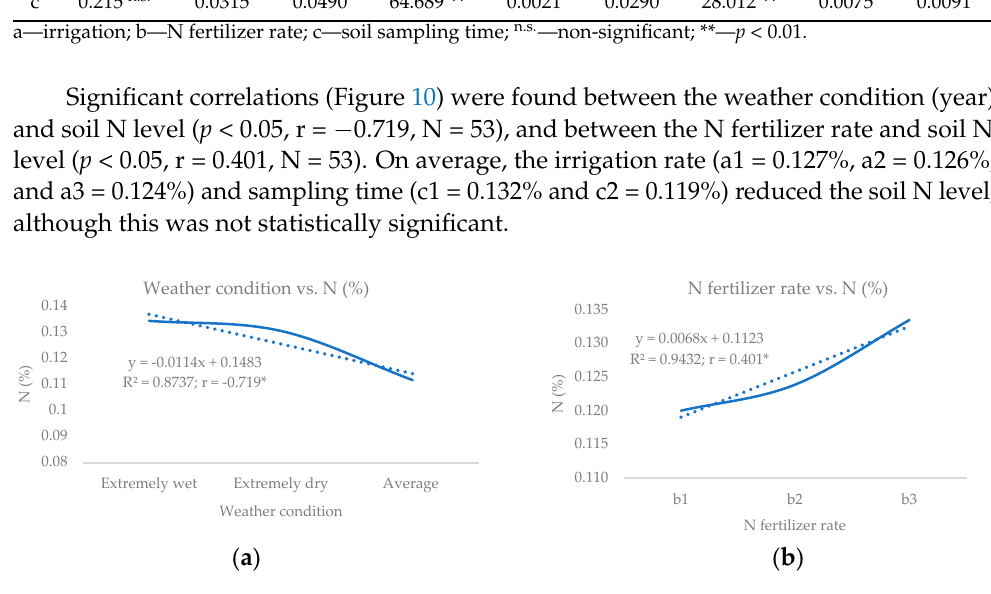
Figure 10. Correlation between ( a ) soil N (%) level and weather conditions (extremely wet, extremely dry and average) and ( b ) soil N (%) level and N fertilizer rate (b1 = 0 kg N ha − 1 , b2 = 100 kg N ha − 1 , b3 = 200 kg N ha − 1 ) significantly different at p < 0.05 (*)